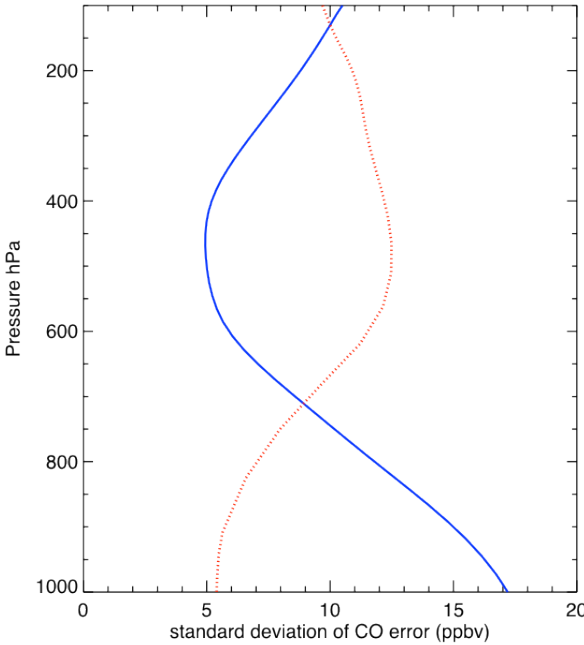
Fig. 3. Prescribed 1-sigma standard deviation of the CO error for AIRS (solid blue line) and TES (dashed red line).